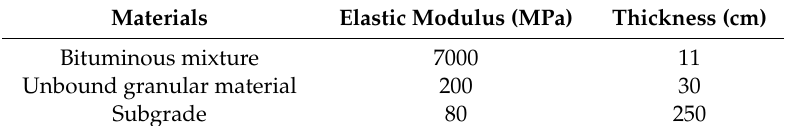
Table 1. Pavement model.